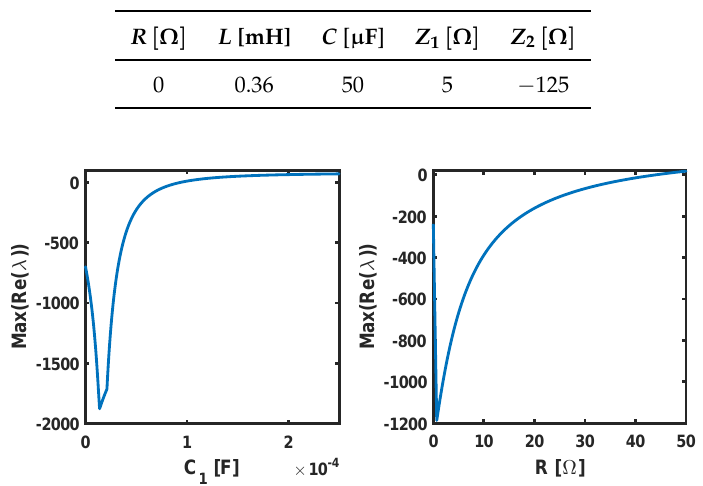
Table 1. System parameters for the sensitivity analysis.